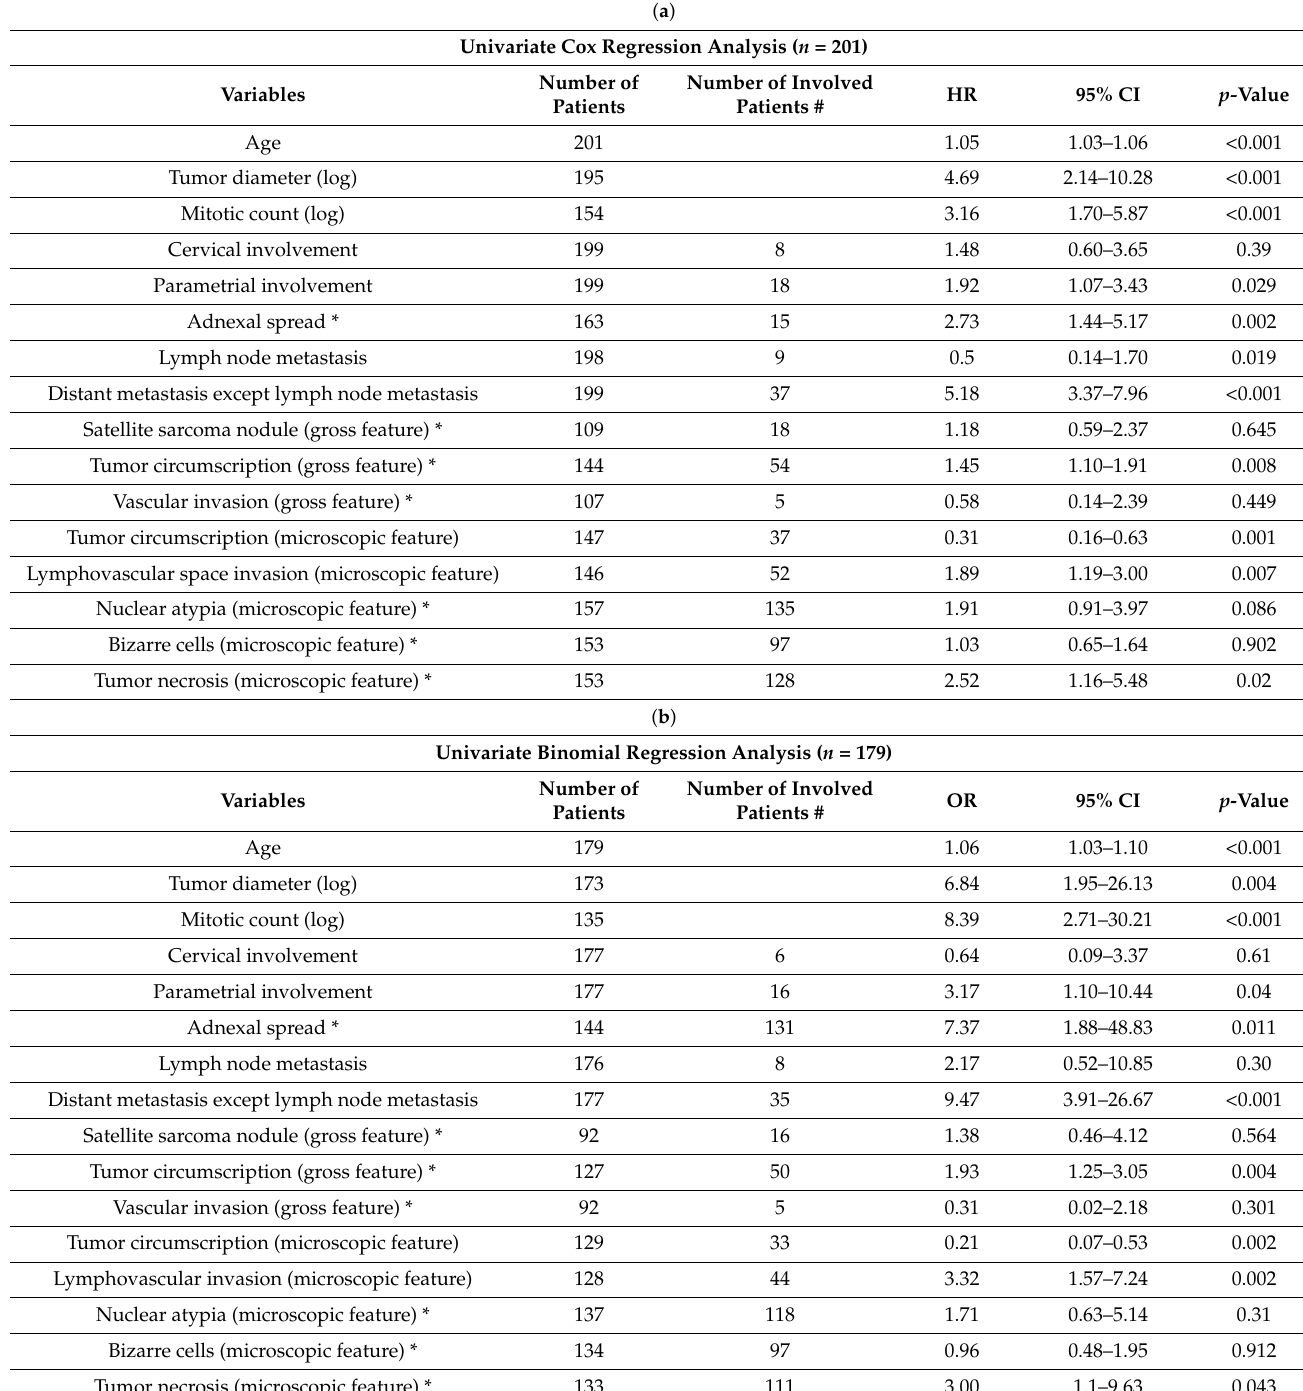
Table 2. ( a ) Univariate Cox regression analysis of 201 patients using overall survival as endpoint. ( b ) Univariate binomial regression analysis of 179 patients using 3-year survival status as